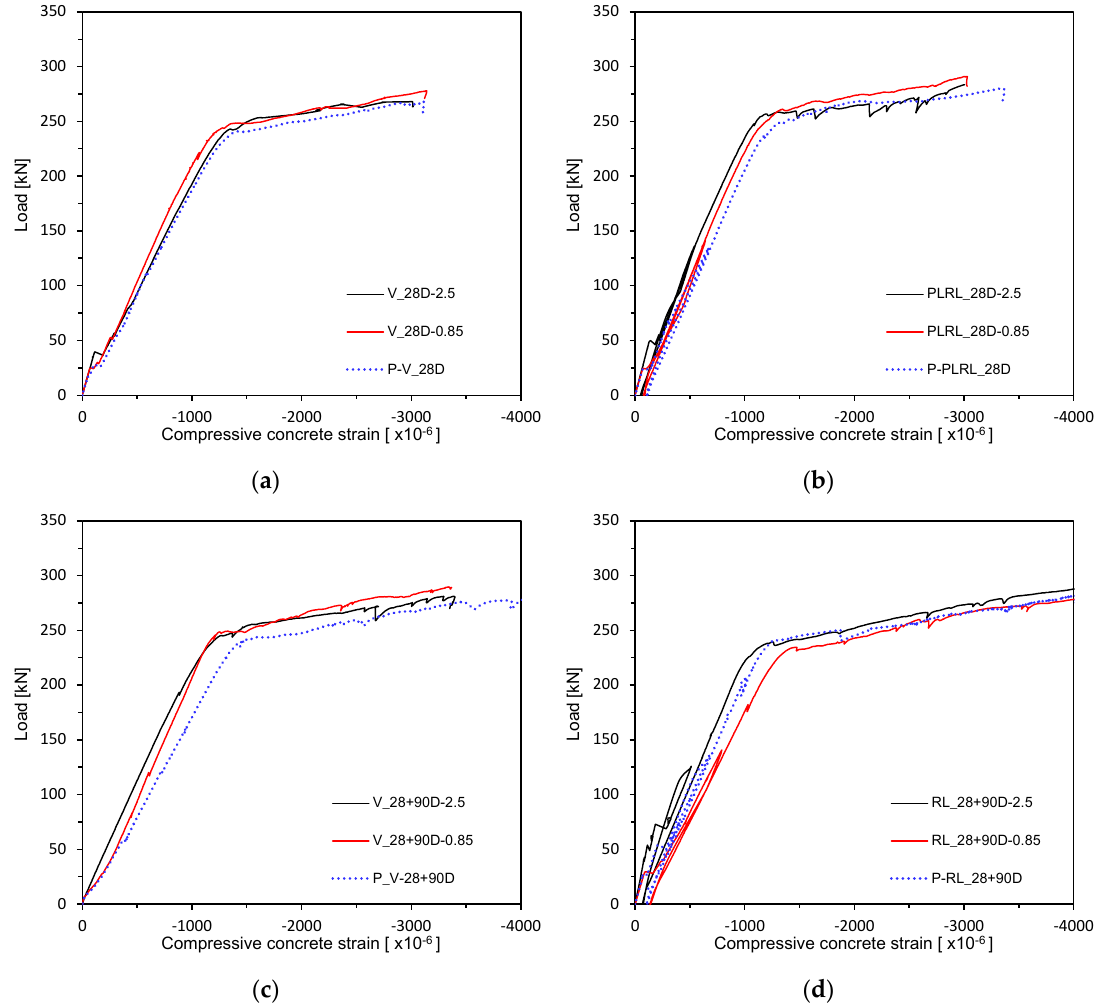
Figure 18. Load–concrete strain measurement by loading conditions: ( a ) V_28D series; ( b ) PLRL_28D series; ( c ) RL_28D series; ( d ) RL_28 + 90D series.